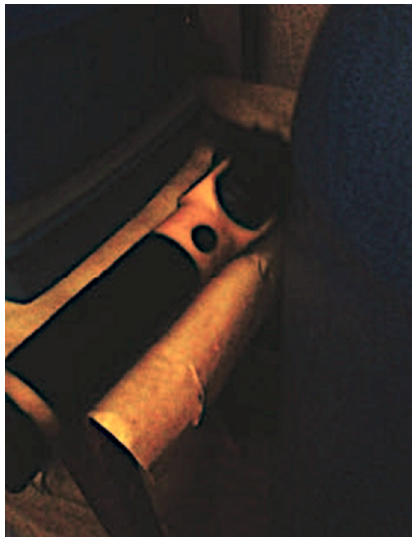
Figure 6. The interior of Joan’s ‘hot-press’, displaying the central heating timer and immersion heater on the left, and torch on the right. Permission granted by Dr. L Shore.